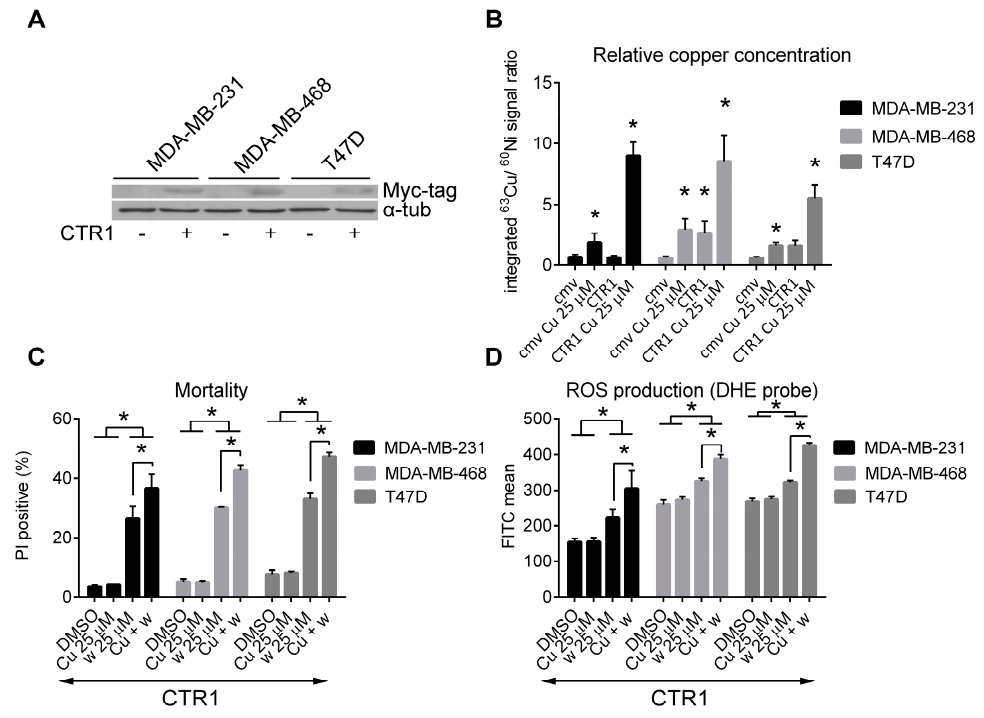
Figure 4. Copper loading enhances cytotoxicity and ROS production in wedelolactone-treated breast cancer cells. MDA-MB-231, MDA-MB-468, and T47D cells were transiently transfected with pCNDA3.1-hCTR1-N-Myc (CTR1) or control pCDNA3.1 plasmids (cmv), pretreated with copper